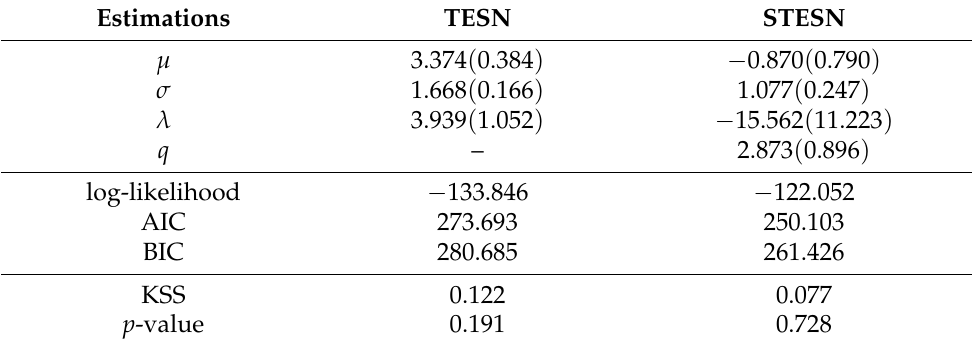
Table 3. Estimated parameters and standard errors (in parentheses), log-likelihood, AIC and BIC values, and KSS with p -values for TESN and STESN models in kevlar